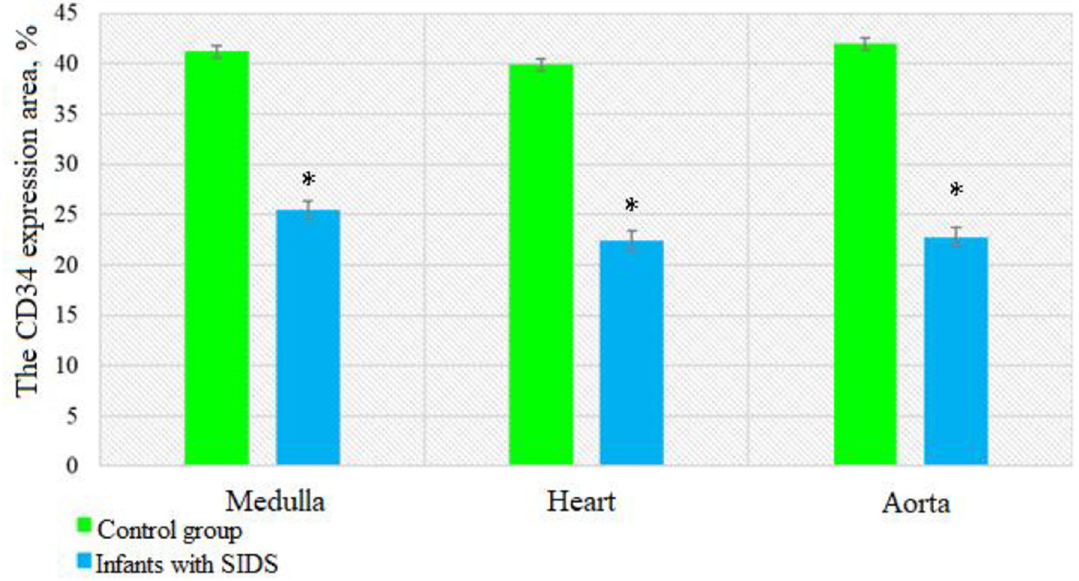
Fig 2. The CD34 expression area (mean ± SD) in medulla, heart, and aorta tissues of infants in the control group and infants with SIDS. � p < 0.05 –as compared with the respective index in the control